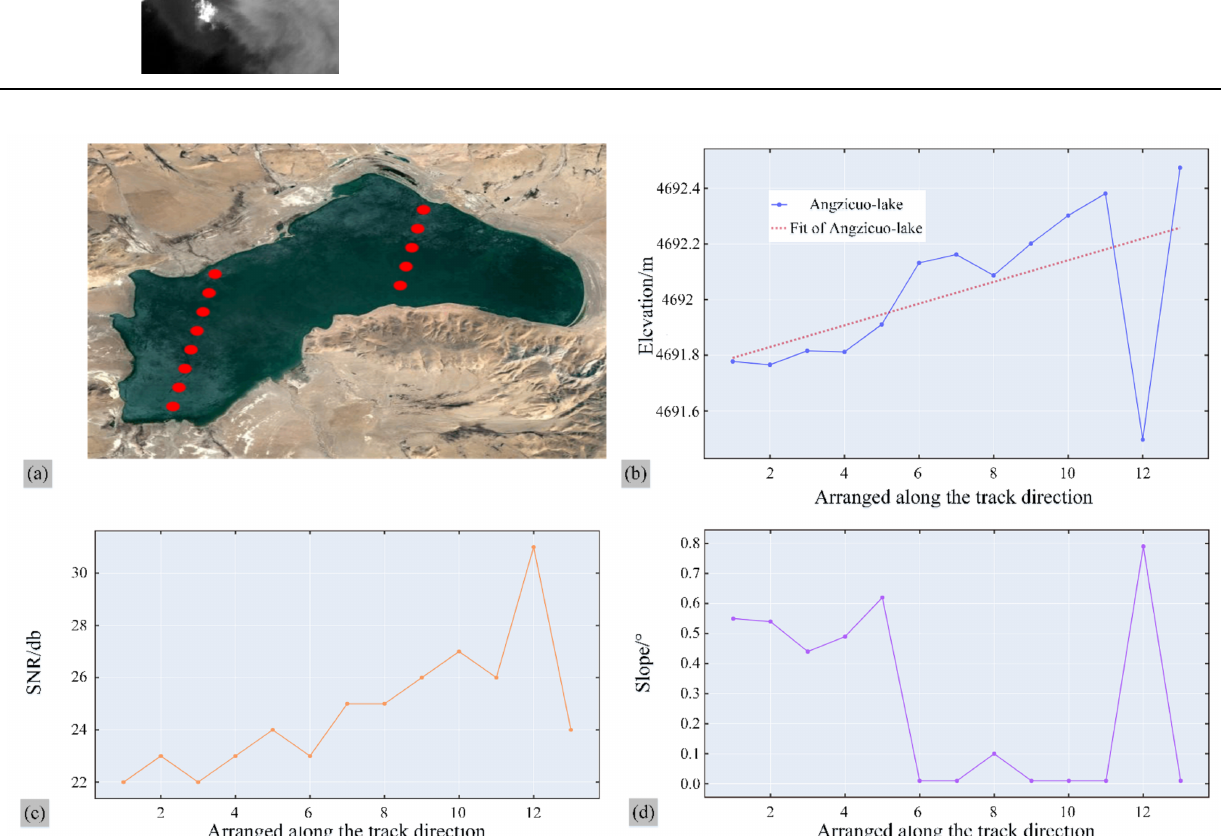
Figure 13. Analysis of the atmospheric scattering effect in the Angzicuo Lake area. ( a ) is the GF-7 satellite image and laser track in the angzicuo lake; ( b ) is the elevation change of laser along the track direction; ( c ) shows the change of SNR of waveform corresponding to laser data; ( d ) shows the slope change corresponding to the laser